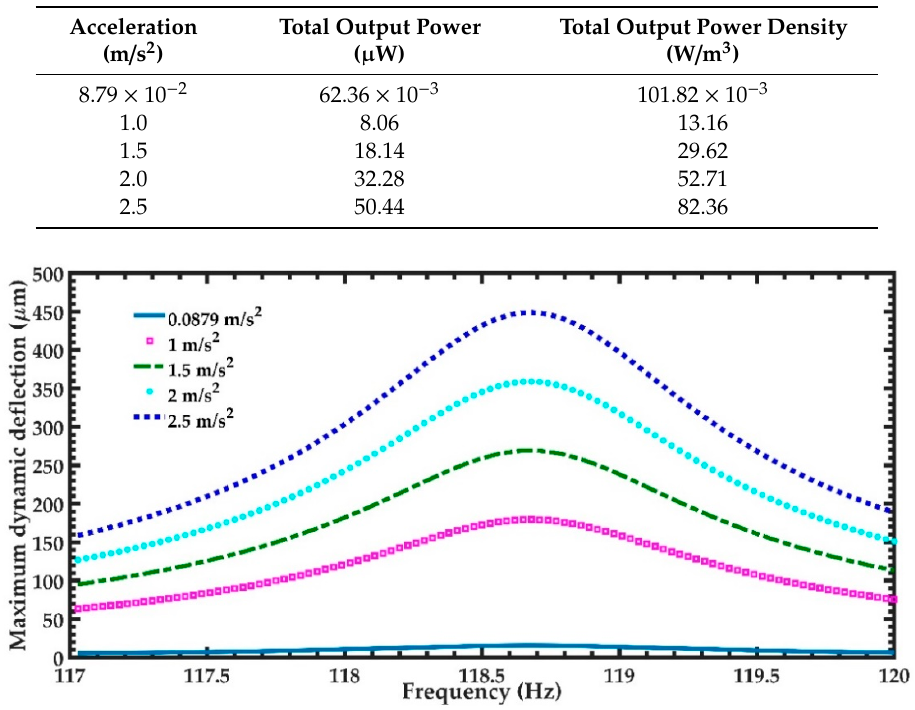
Figure 14. Maximum normal stress in x -direction of the nanogenerator regarding four different accelerations in y -direction and a frequency range from 117 to 120 Hz. Figure 15. Maximum normal stress in y -direction of the nanogenerator considering four different accelerations in y -direction and a frequency range from 117 to 120 Hz.